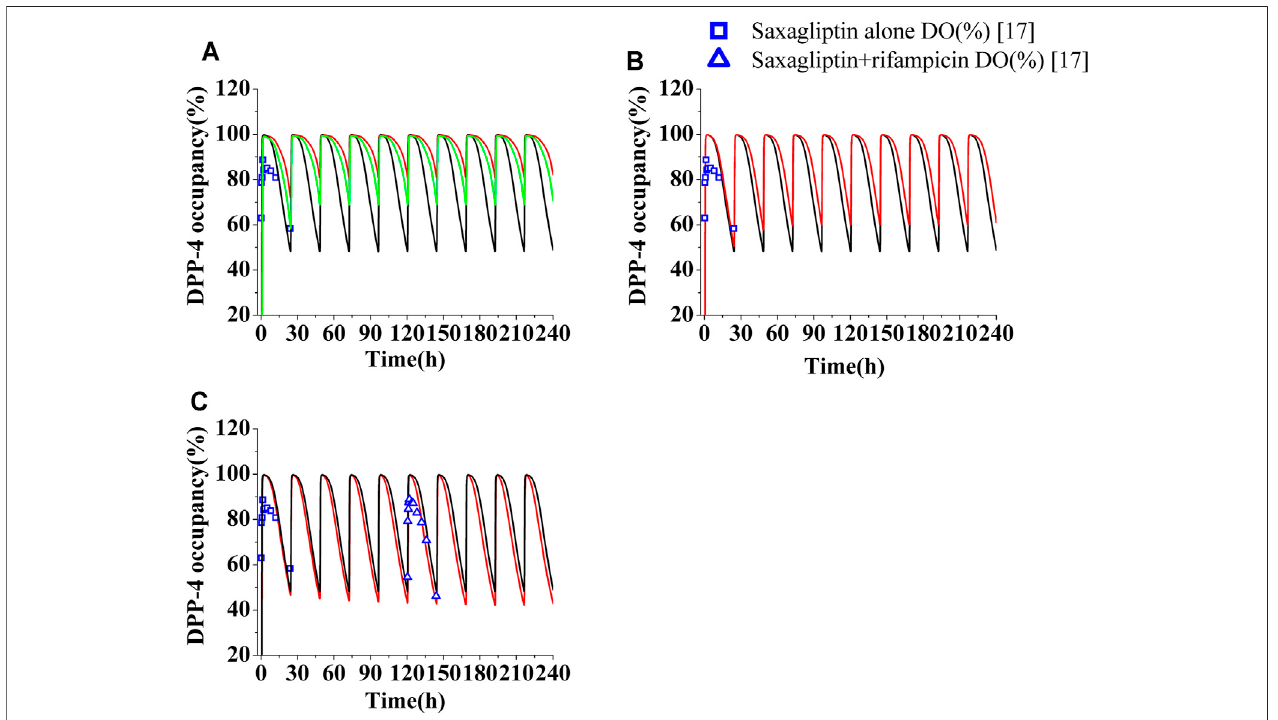
FIGURE 4 | Human DPP-4 occupancy by saxagliptin and M2 following coadministration of inhibitors or inducers. (A) Human DPP-4 by saxagliptin of 5 mg ( ∩ ) and 2.5 mg ( ∩ ) with ketoconazole (200 mg, twice daily). (B) Human DPP-4 by saxagliptin of 5 mg ( ∩ ) with delavirdine (400 ° mg, twice daily). (C) Human DPP-4 by saxagliptin of 5 mg ( ∩ ) with rifampicin (600 ° mg, once daily). The black lines ( ∩ ) represent human DPP-4 by saxagliptin of 5 mg without inhibitors/inducers. The blue squares ( □ ) and blue up-triangles ( △ ) refer to observed DPP-4 occupancy data of saxagliptin and M2 without inhibitors/ inducers and observed DPP-4 occupancy data of saxagliptin and M2 with rifampicin on the sixth day,